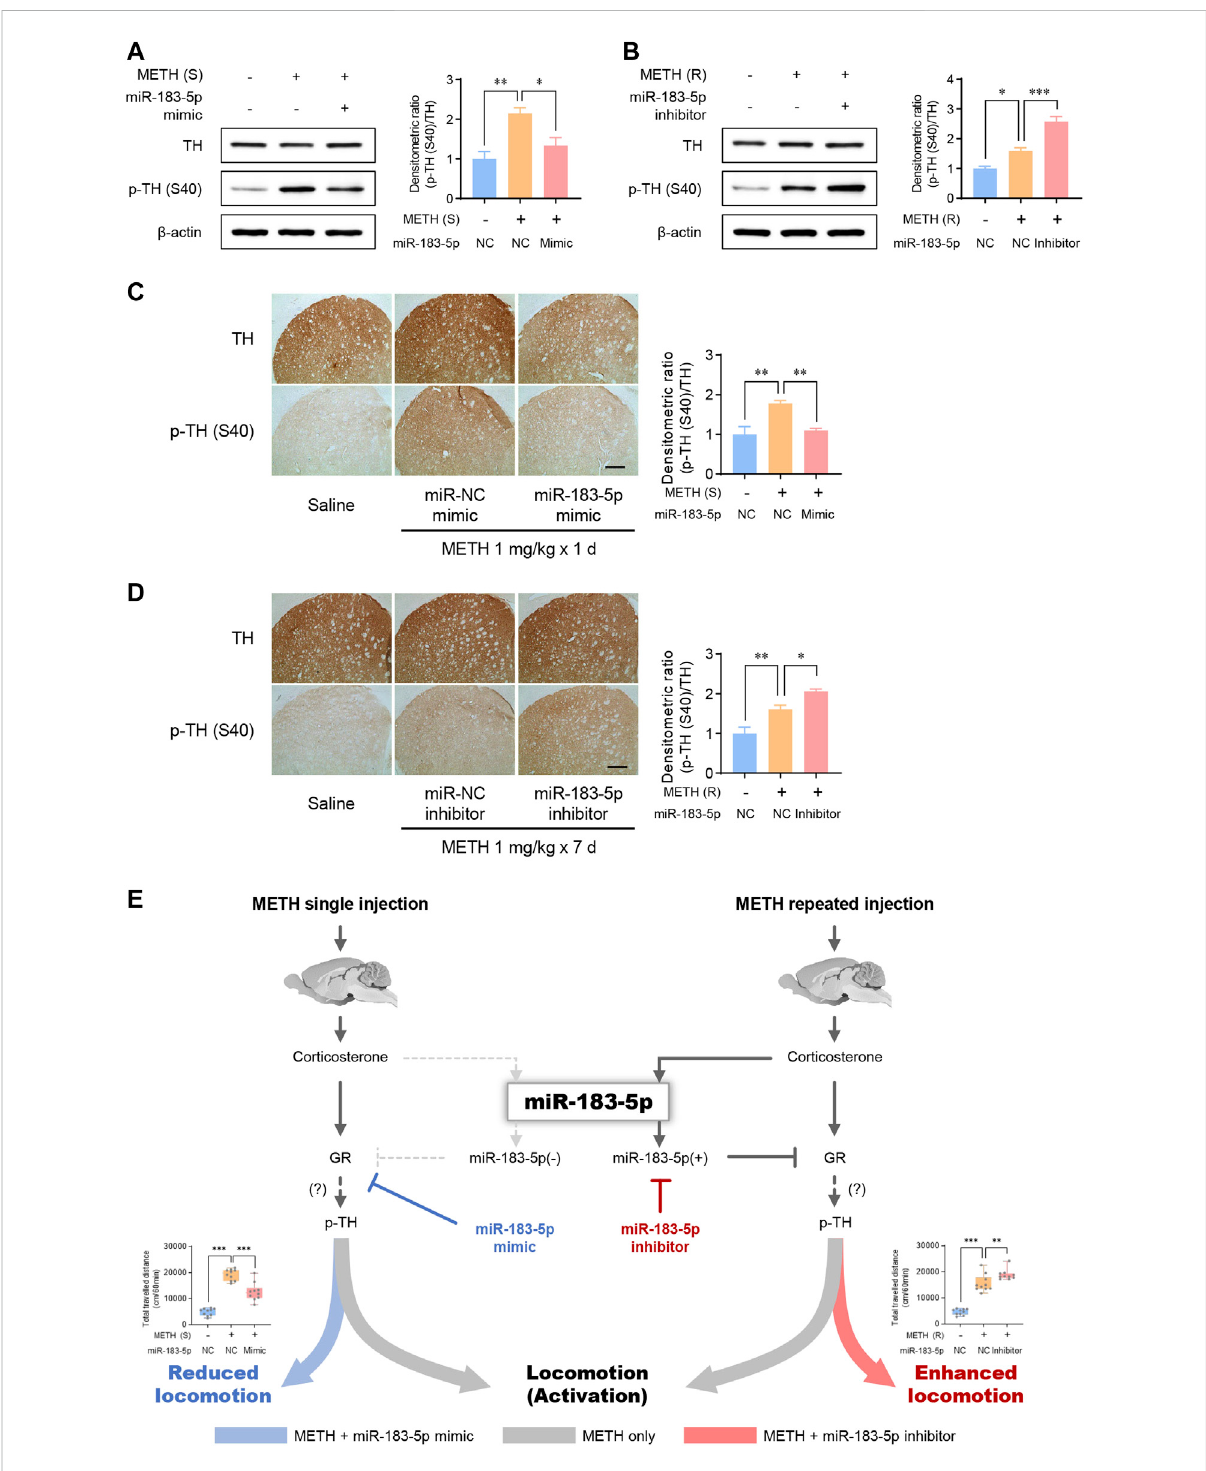
FIGURE 5 MiR-183-5p downregulatedGR-TH signaling inthestriatum ofrats. (A,B) WesternblotanalysisofTHandp-TH(S40)expressioninthestriatum. Theimmunoblotswerenormalizedto β -actin.Quanti fi cationoftherelativeblotintensityofproteinswasperformedusingImageJsoftware.Dataare presented as the fold change relative to the control group. Statistical analyses were performed using the one-way ANOVA. Error bars represent mean ± SEM ( n = 5). * p < 0.05, ** p < 0.01. (C,D) Immunohistochemical detection of TH and p-TH (S40) in the striatum. Scale bar = 500 μ m. Quanti fi cationoftherelativeintensityofproteinswasperformedusingImageJsoftware.Dataarepresentedasthefoldchangerelativetothecontrol group. Statistical analyses were performed using the one-way ANOVA. Error bars represent mean ± SEM ( n = 5). * p < 0.05, ** p < 0.01. (E) Proposed mechanism by which miR-183-5p controls METH-induced locomotor